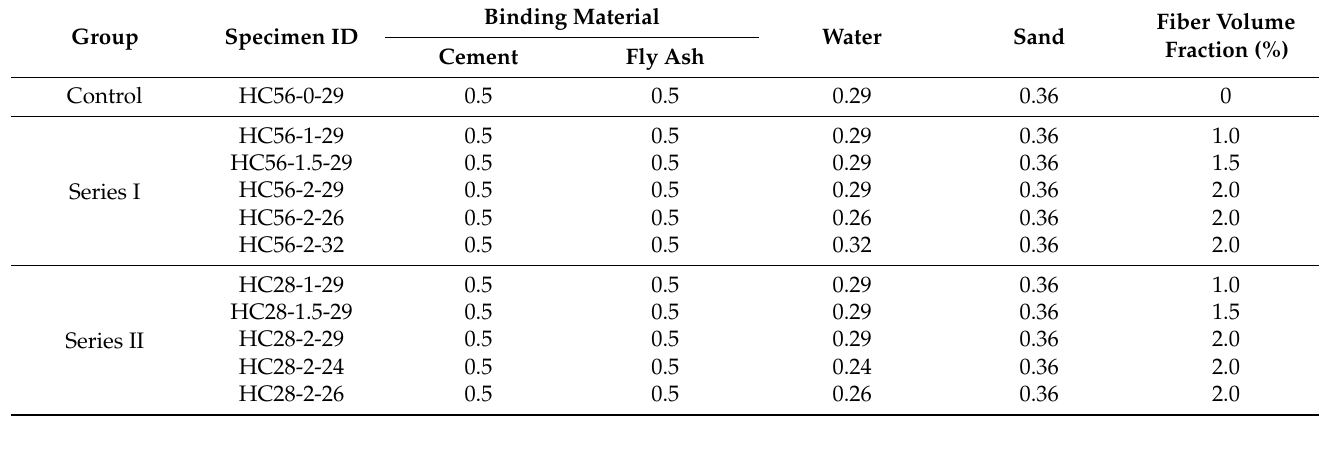
Figure 1. Short polyvinyl alcohol (PVA) fiber.